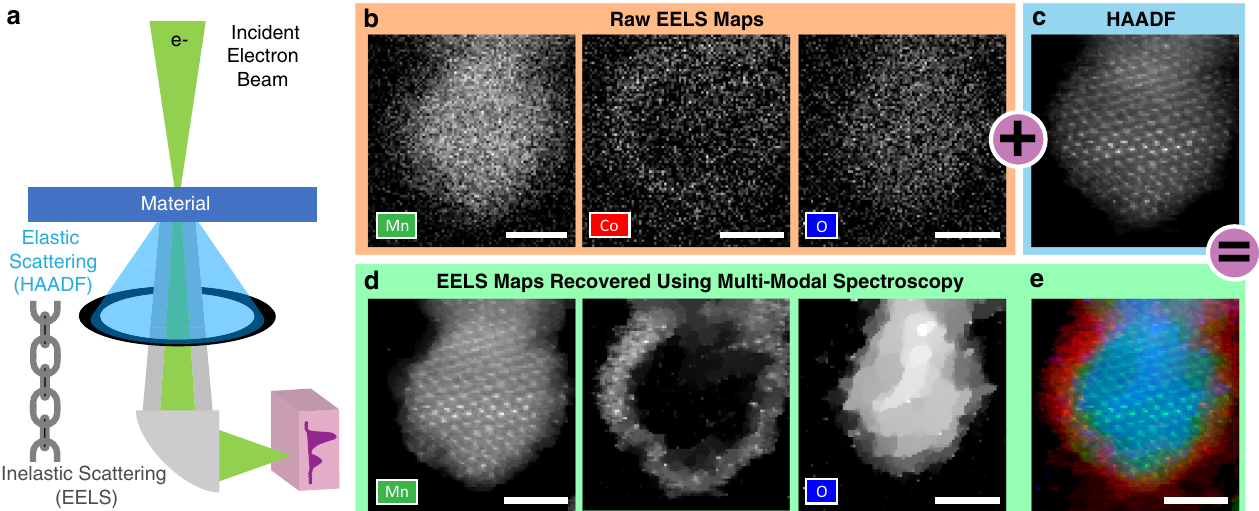
Fig. 2 Atomic-scale multi-modal chemical recovery of Co 3 − x Mn x O 4 supercapacitors using EELS + HAADF. a Schematic highlighting the linked HAADF and EELS modalities collected in the microscope at every probe position. b Raw EELS maps for the elemental distributions of Co, Mn-L 2,3 and O – K edges. c The simultaneous HAADF micrograph of the Co 3 − x Mn x O 4 nanoparticle. d The multi-modal reconstructions for the elemental distributions. e EELS RGB overlay of the Co, S, and O maps. Scale bar, 2